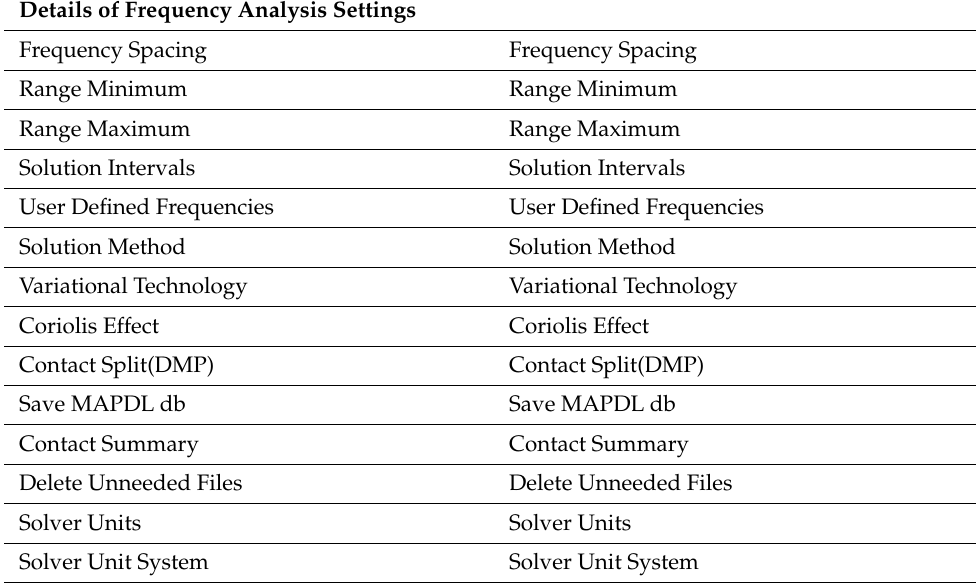
Table 6. Details of frequency analysis settings.